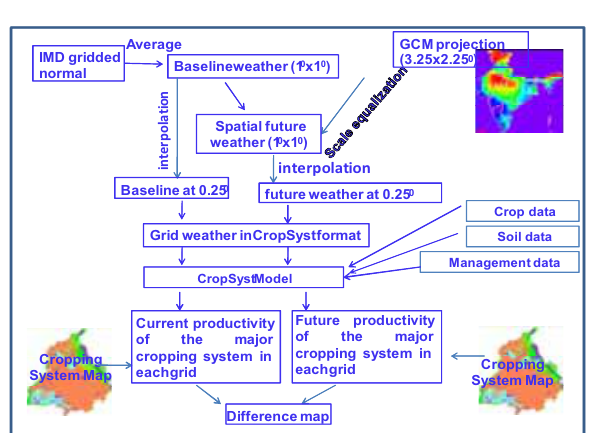
Figure 3. Schematic representation of the methodology followed